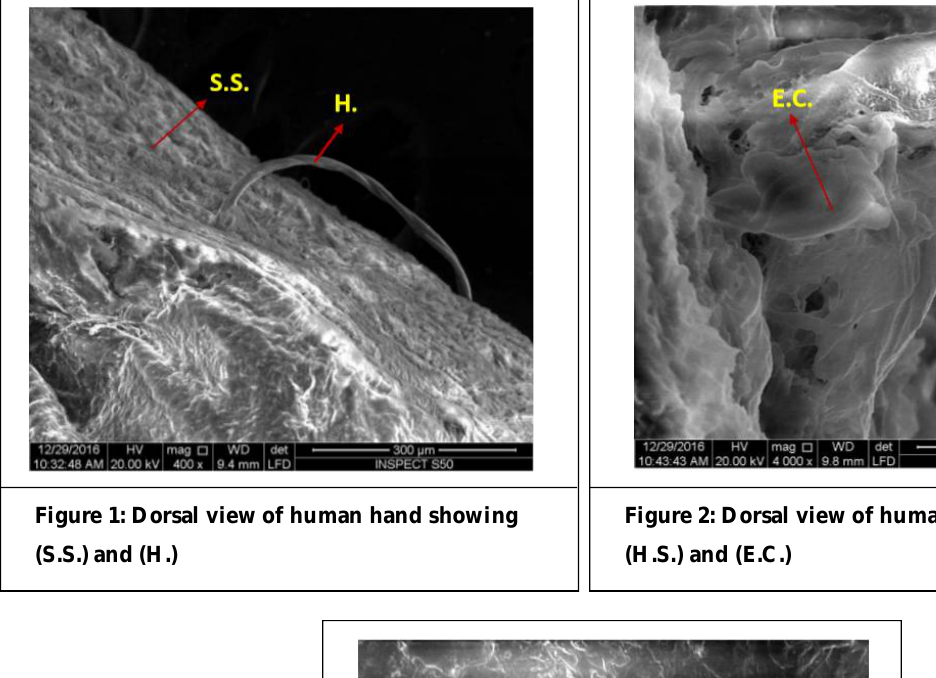
Figure 1: Dorsal view of human hand showing (S.S.) and (H.)